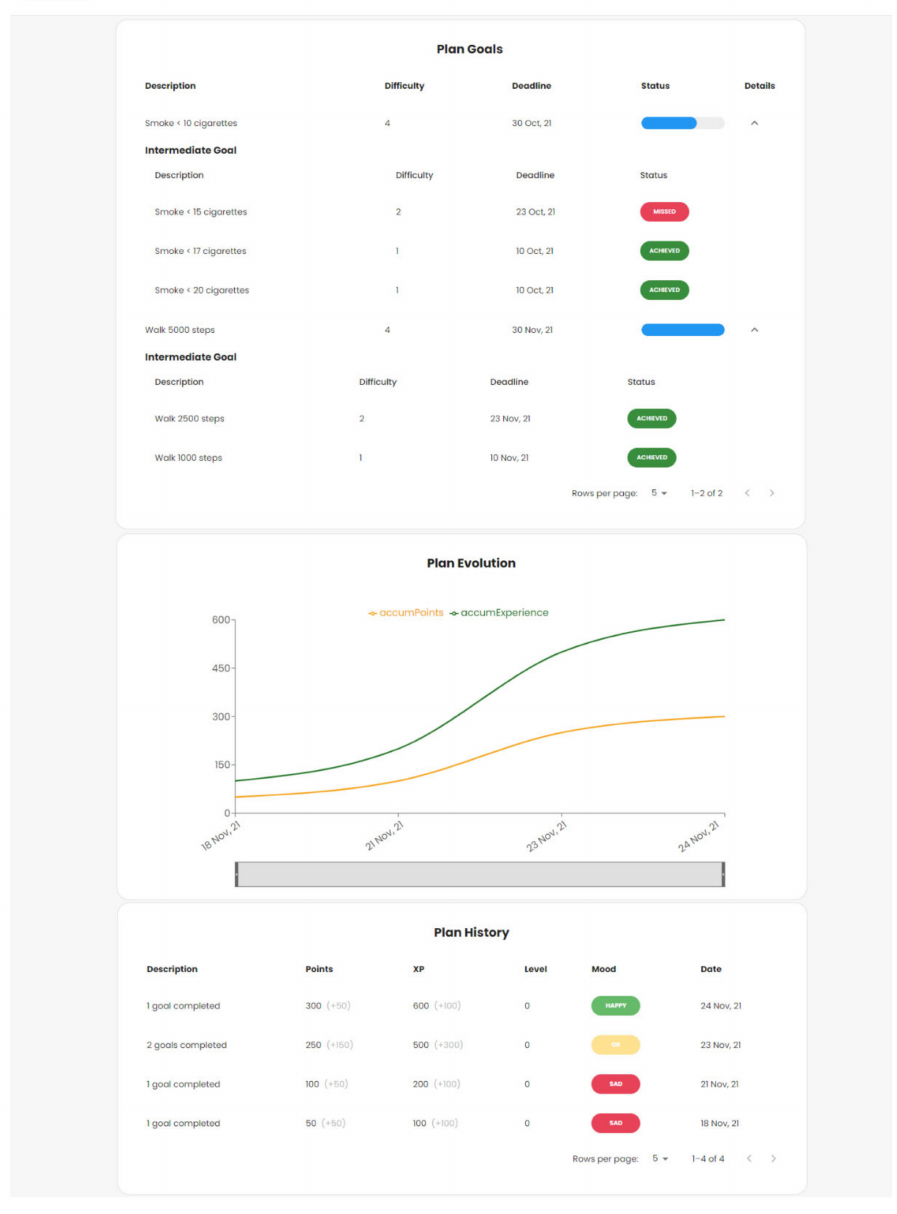
Figure 6. Coaching plan details